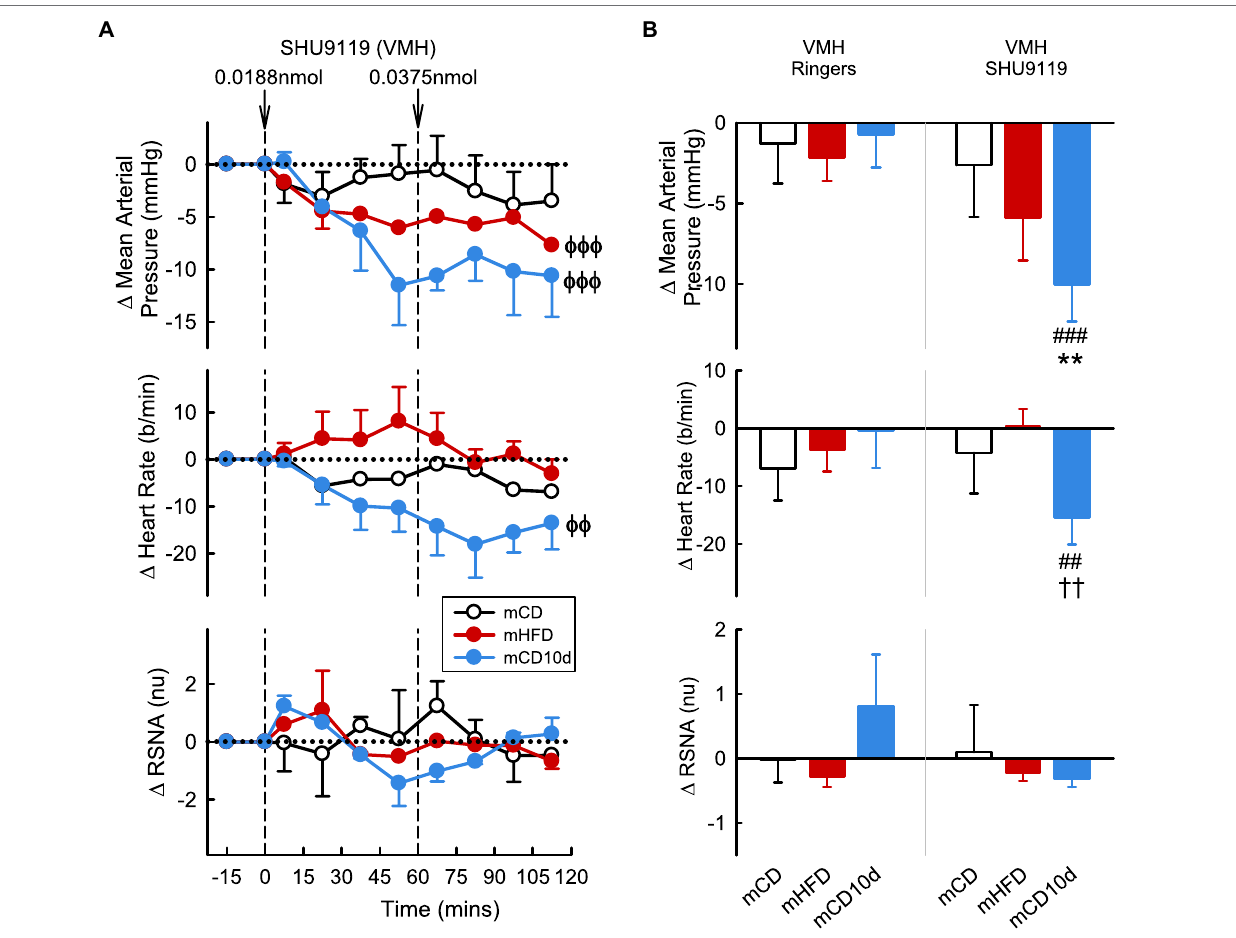
FIGURE 9 | Effects of SHU9119 injected in the VMH. (A) Average changes MAP, heart rate, and RSNA (normalized units) from control in each group after VMH injection of SHU9119 (0.0188 nmol, 0.0375 nmol) in mCD (white, n = 5), mHFD (red, n = 6), and mCD10d (blue, n = 3) rabbits. Data are mean difference ± SED. ϕϕ p < 0.01, ϕϕϕ p < 0.001 for average effect of SHU9119. (B) Changes from control after administration of vehicle Ringer’s and SHU9119, averaged over second dose, given into the VMH in mCD, mHFD, and mCD10d rabbits. Data are mean difference ± SED from the control period of each treatment group. ** p < 0.01 for comparison to mCD; †† p < 0.01 for mHFD vs. mCD10d; and ## p < 0.01 and ### p < 0.001 for effect of SHU9119 vs.